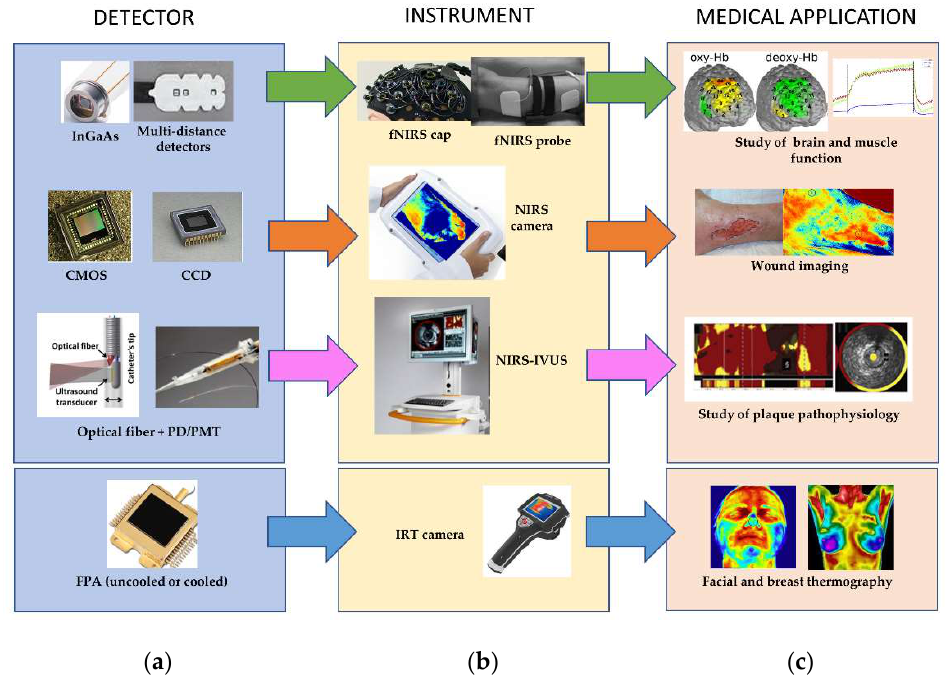
Figure 2. Typical detectors ( a ), instruments ( b ), and medical applications ( c ) of near-infrared spec- troscopy (NIRS) and infrared thermal (IRT) imaging. troscopy (NIRS) and infrared thermal (IRT)